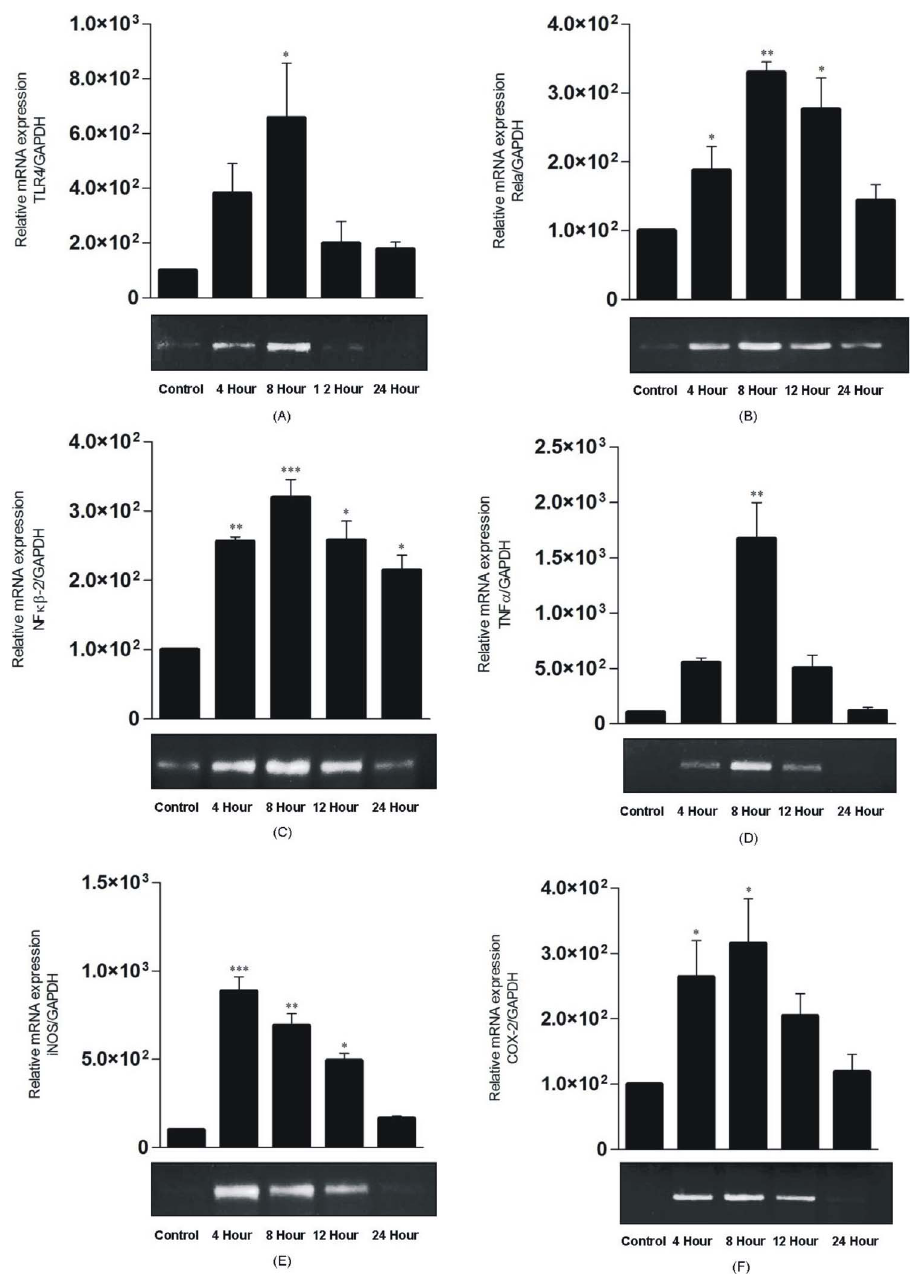
Figure 6. Effect of purified endotoxin on relative mRNA expression of TLR4, RelA, NF-kB2, TNF- a , iNOS, COX-2 genes (GAPDH as control gene) in liver tissue of mice (* P , 0.05, ** p , 0.01 and ** p ,